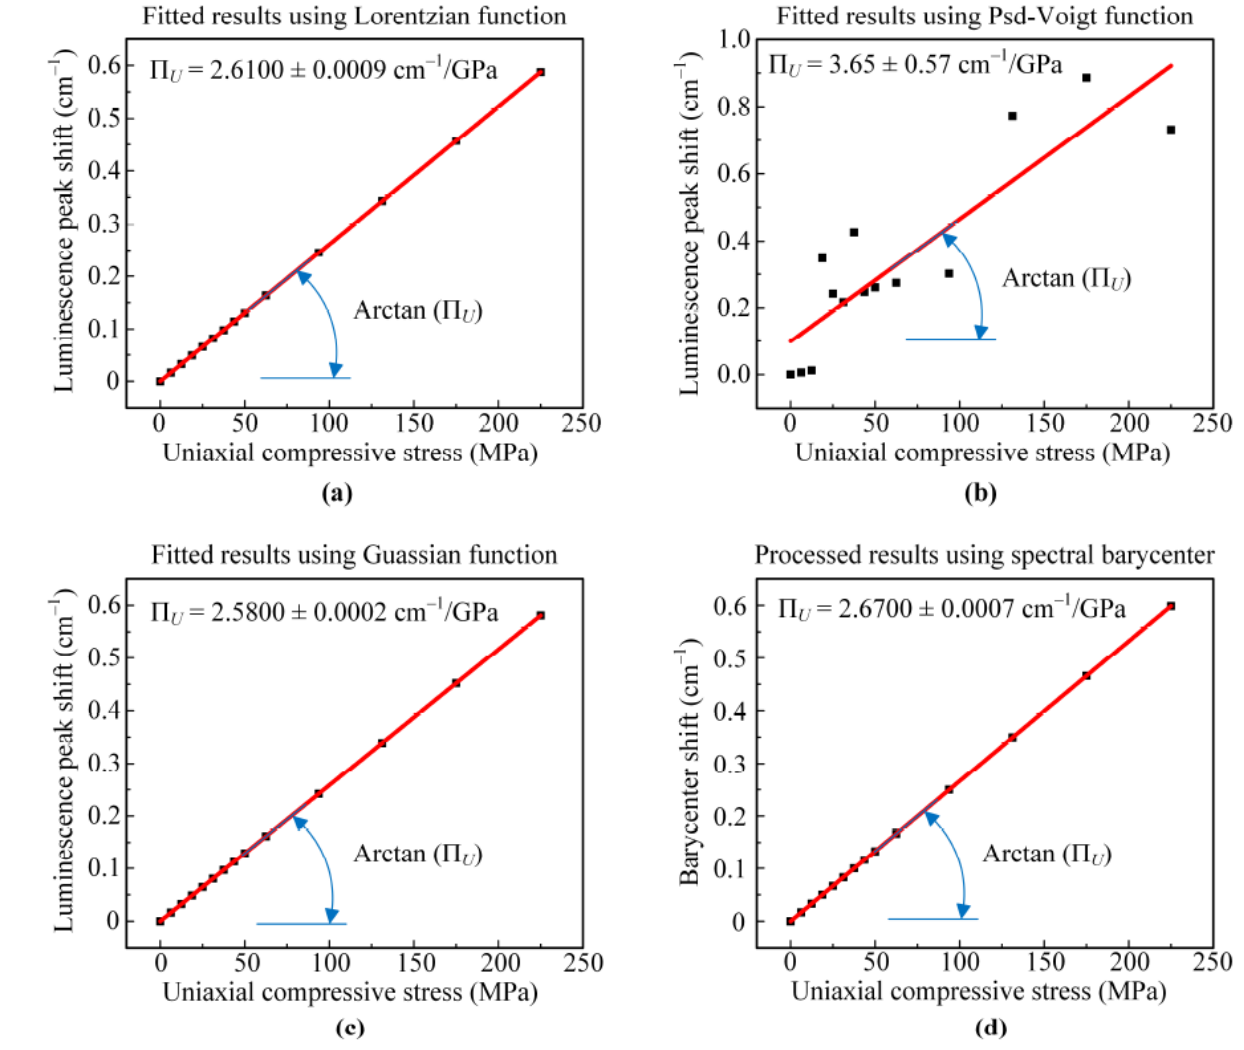
Table 2. GOF values for different functions used to fit Eu 3+ fluorescence spectra.